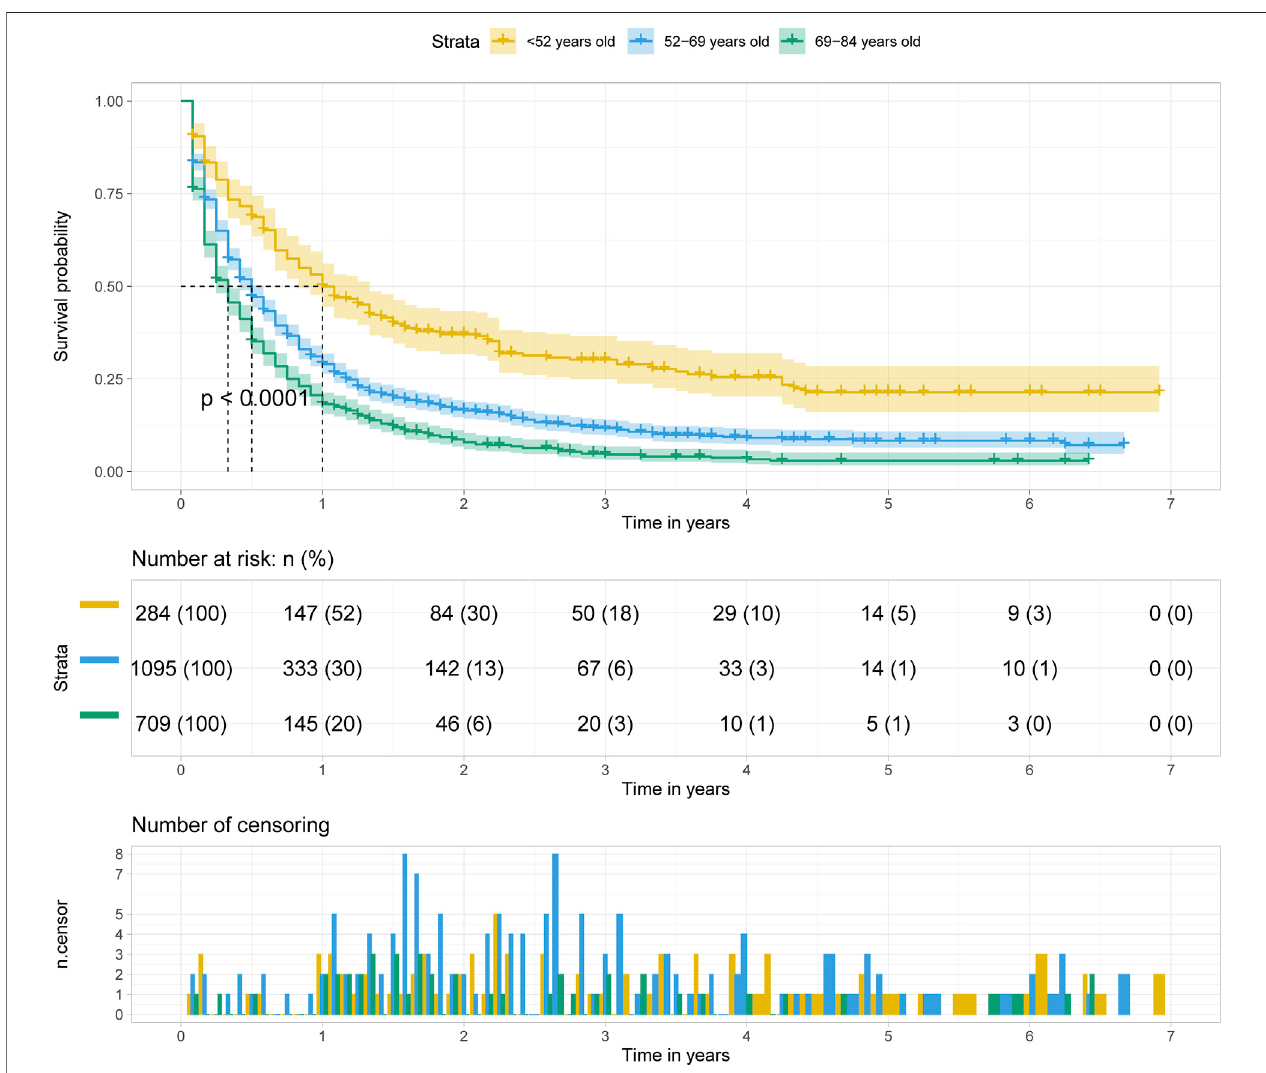
FIGURE 4 | Kalpan Meier survival curve showing the effect of age at diagnosis with pancreatic cancer metastasis to liver.